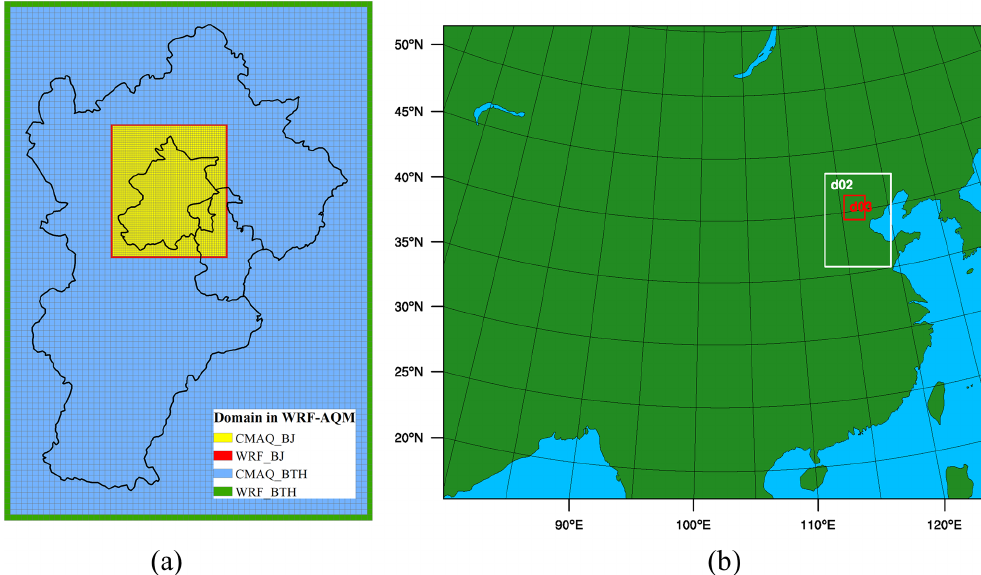
Figure 5. ISAT-configured WRF-AQM nested